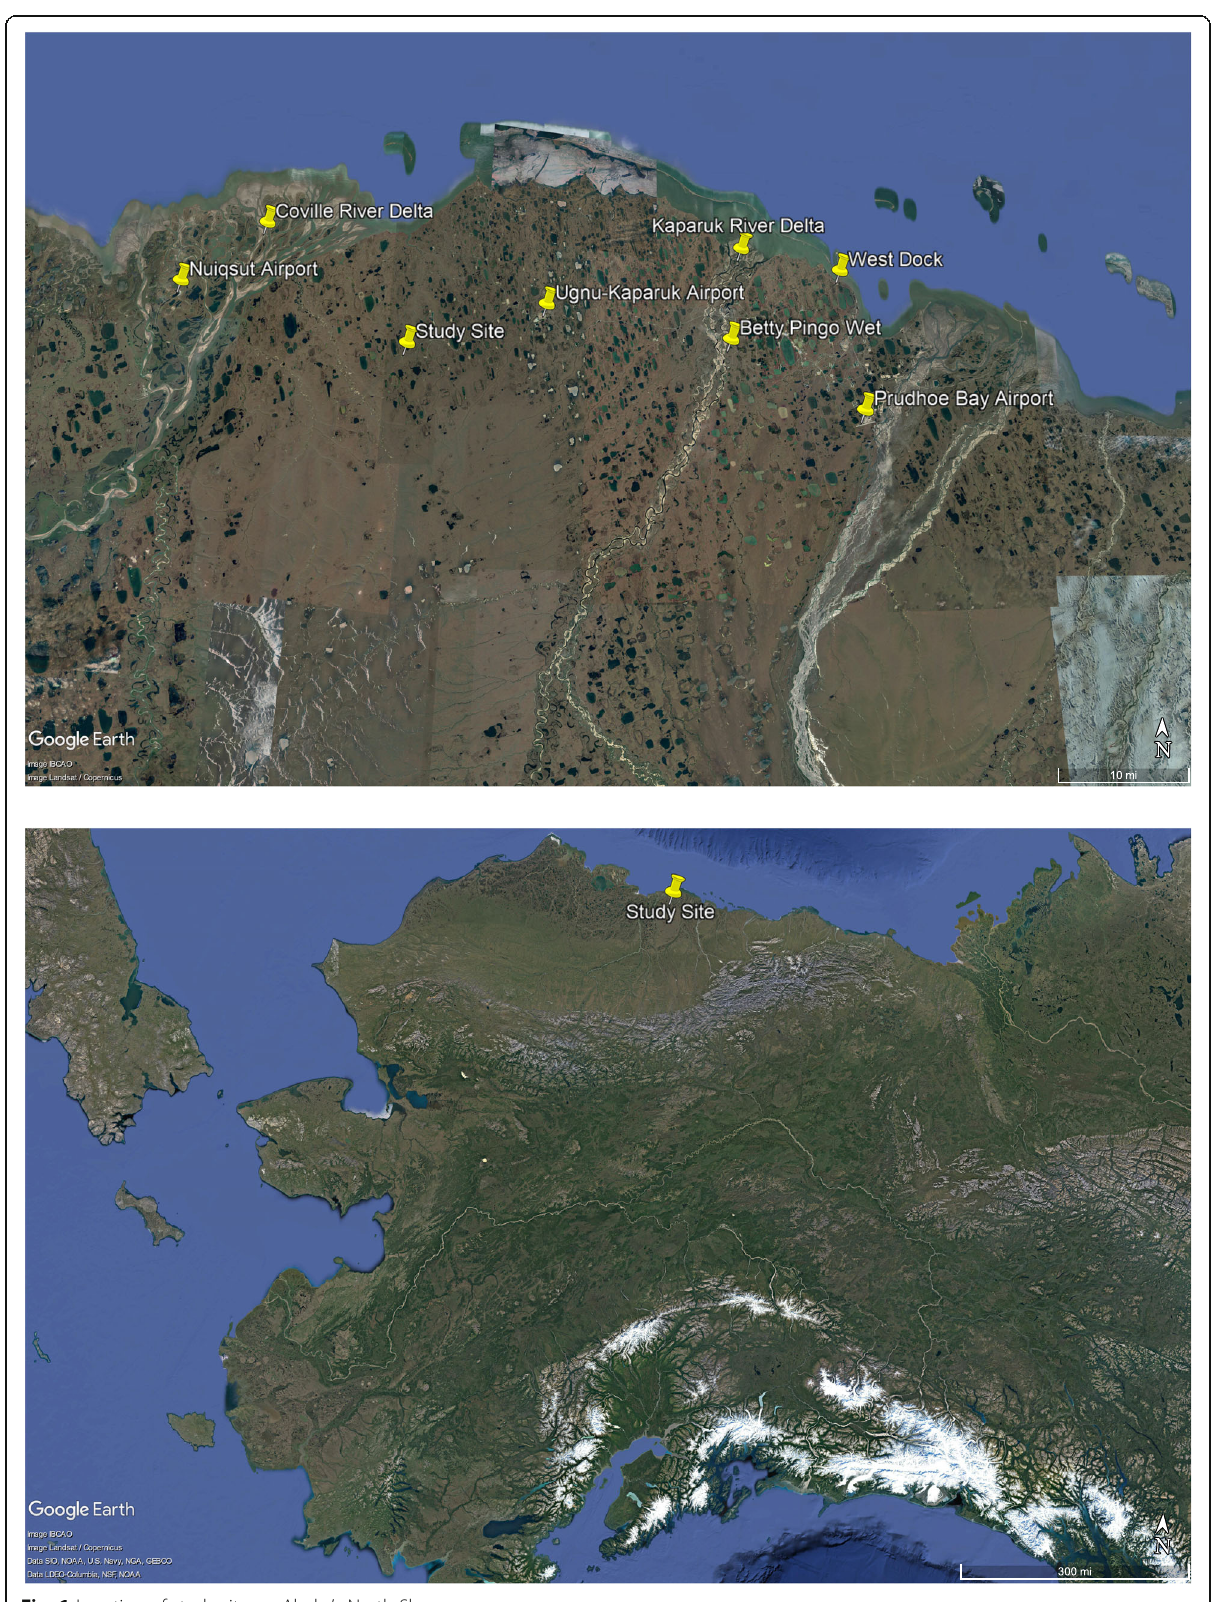
Fig. 1 Location of study site on Alaska ’ s North